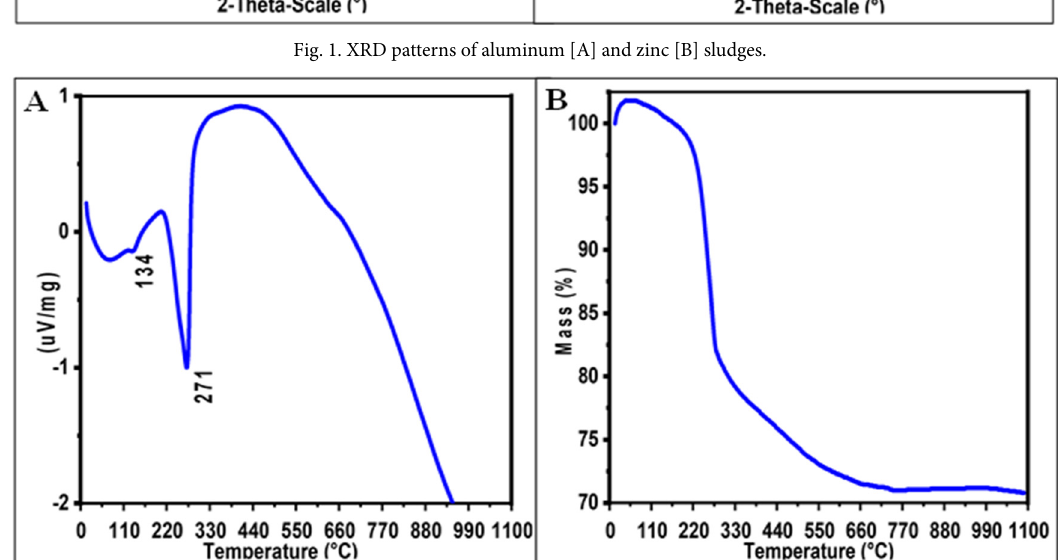
Fig. 2. differential thermal analysis in terms of DSC [A] and TG [B] of sludges’